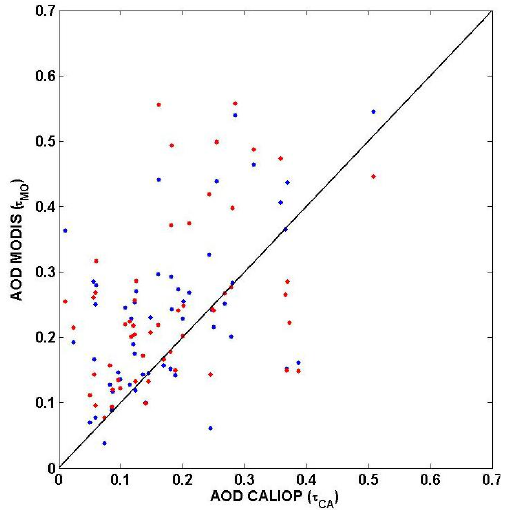
Fig. 6: Comparison between of AOD derived from CALIOP (  CA ) and from MODIS (  MO ) Aqua (blue dots) or Terra (red dots). Fig. 6. Comparison between of AOD derived from CALIOP ( τ CA ) and from MODIS ( τ MO ) Aqua (blue dots) or Terra (red